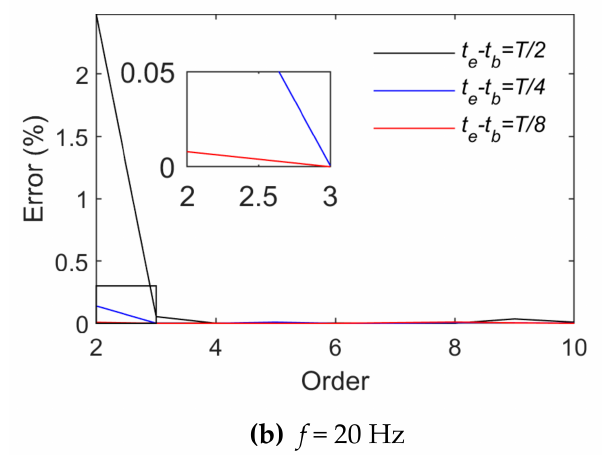
Figure 4. Fitting effects of harmonic loads (Case 2).